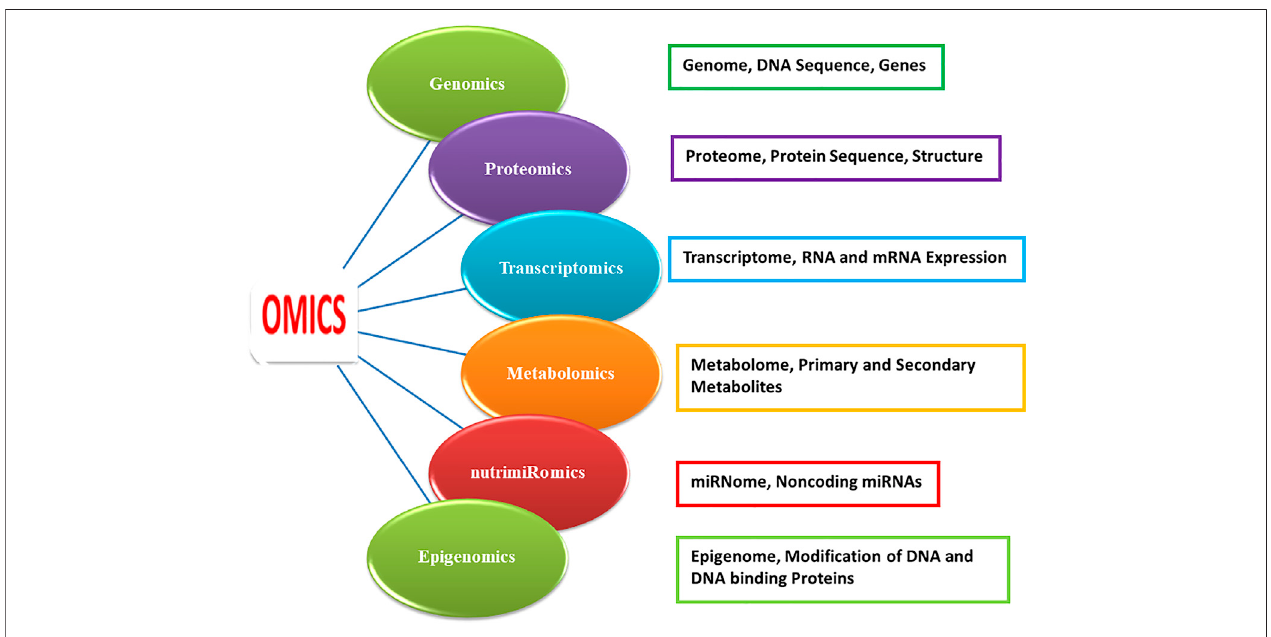
FIGURE 1 | Omics branches with their